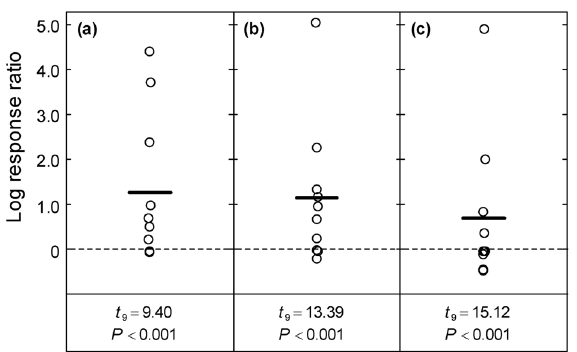
Figure 4. Multifunctionality in mixtures at N50 compared to different types of communities at N450 expressed as the mean log response ratio (MLRR) (horizontal line) across ten functions (circles). The log response ratio for each function was calculated for the four-species equi-proportional mixture at N50 against ( a ) the average of the two grass monocultures at N450, ( b ) the average of all monocultures at N450, and c) the four-species equi- proportional mixture at N450 (N50: 50 kg N ha −1 yr −1 , N450: 450 kg N ha −1 yr −1 ). Data were averaged across years, and LRRs of functions were calculated based on multivariate regression analysis (Table 2). The inference ( t - and P -values) refers to a test of the MLRR against zero. Circles are scattered horizontally to improve their